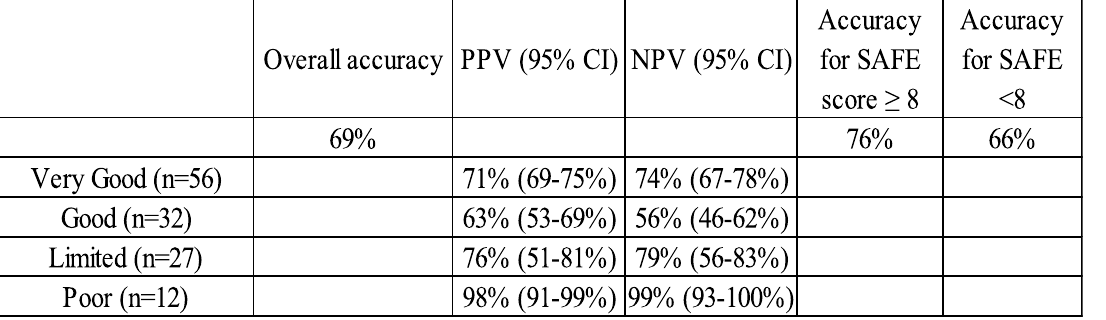
Table 3 The accuracy and negative and positive predictive values of the APRAHL